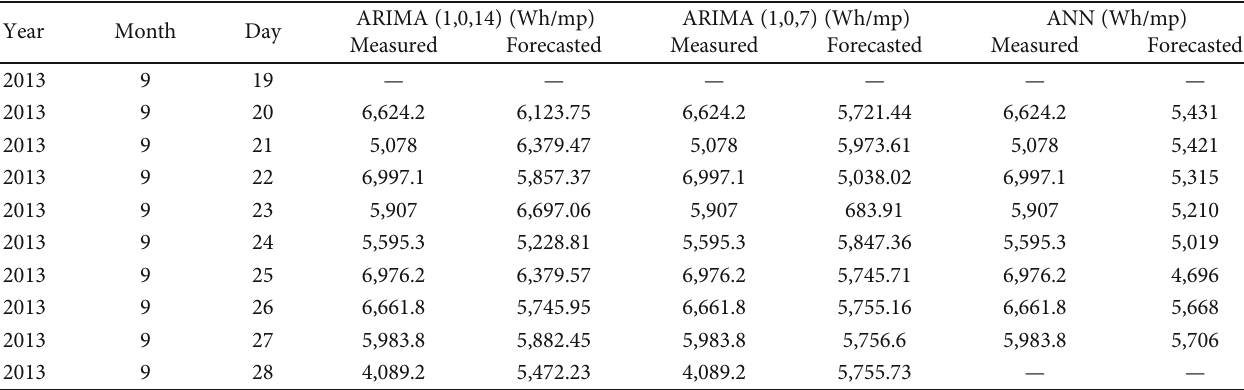
Table 8: Measured and forecasted values for 10 days, September 2013, based on ARIMA and ANN models. This table is reproduced from [35] under the permission of the editor.